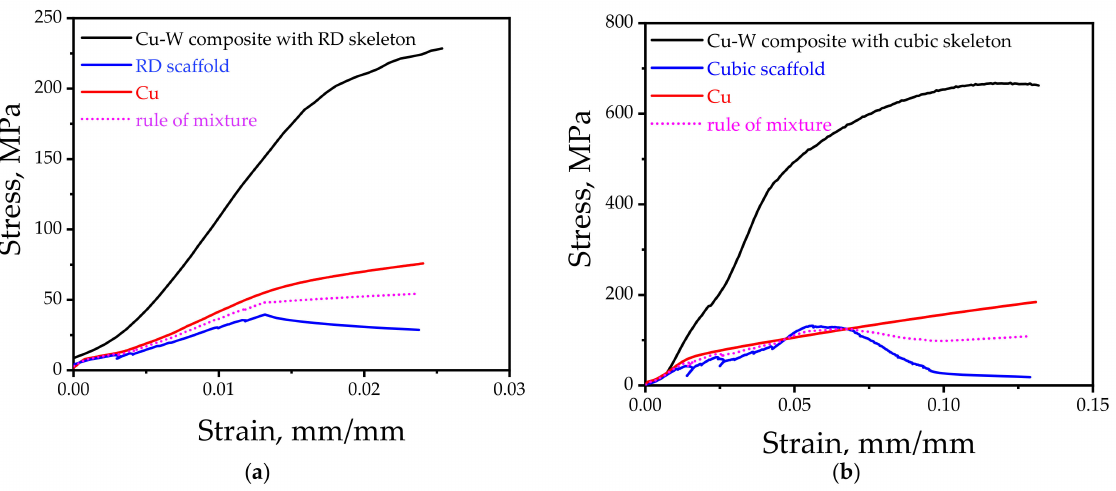
Figure 9. The engineering compressive stress–strain curves of the Cu-W composite at ambient temperature with the rhombic dodecahedron (RD) ( a ) and cubic ( b ) skeleton, and their comparison with those of the pure copper, W scaffold, and their combination according to the rule-of-mixtures. Figure 10 reflects the deformation images of the Cu and W constituents in the cubic and rhombic dodecahedron-skeleton composites, respectively, during the process of com- pression. As can be seen from the figure, during the deformation process, the failure of the composites takes place inside the W-skeleton. Cracks initiate from the W-skeleton first (Figure 10) and connect together, then extend and cross the whole skeleton with the increase in strain, causing the W-skeleton to be damaged on a large scale (Figures 10 and 11). The Cu matrix experiences a substantial deformation throughout compression, but the composites remain intact (Figure 11).